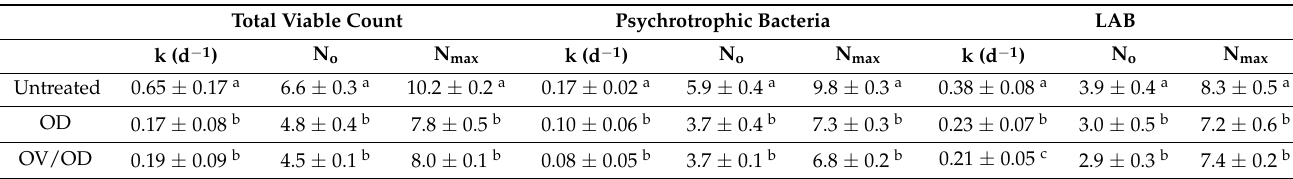
Table 1. Growth rates and final population of the total viable count. Psychrotrophic and LAB of chicken fillet samples stored at 4 ◦ C (mean values ± standard error based on the statistical variation in the kinetic parameters of the Baranyi growth model—regression analysis).